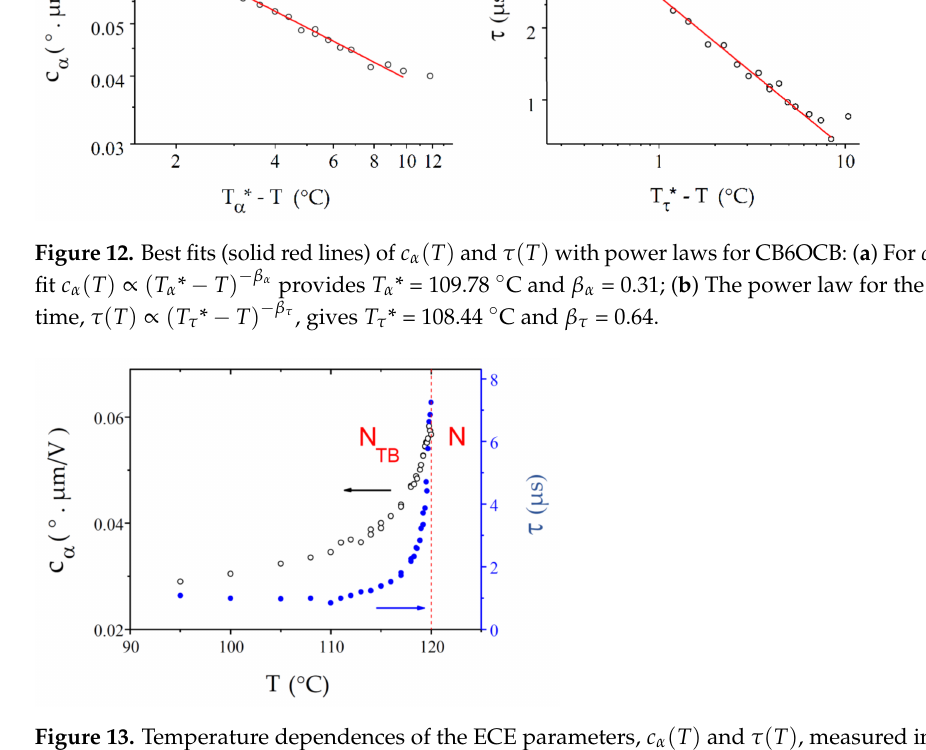
Figure 13. Temperature dependences of the ECE parameters, c α ( T ) and τ ( T ) , measured in the N TB phase of the dimer BNA76. The N-N TB phase transition takes place at T c = 120.00 ◦ C and the N-N TB biphasic coexistence temperature range is very narrow, almost undetectable.